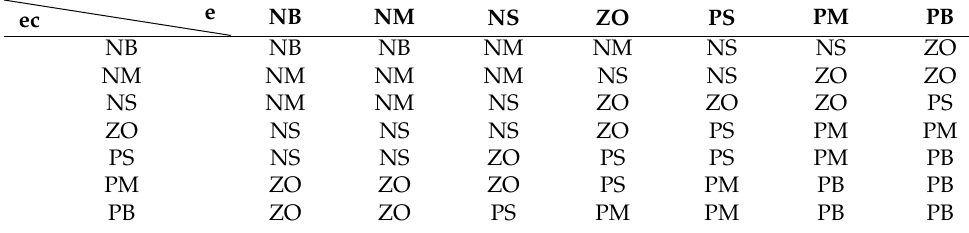
Table 4. Integration (I) fuzzy rule table.